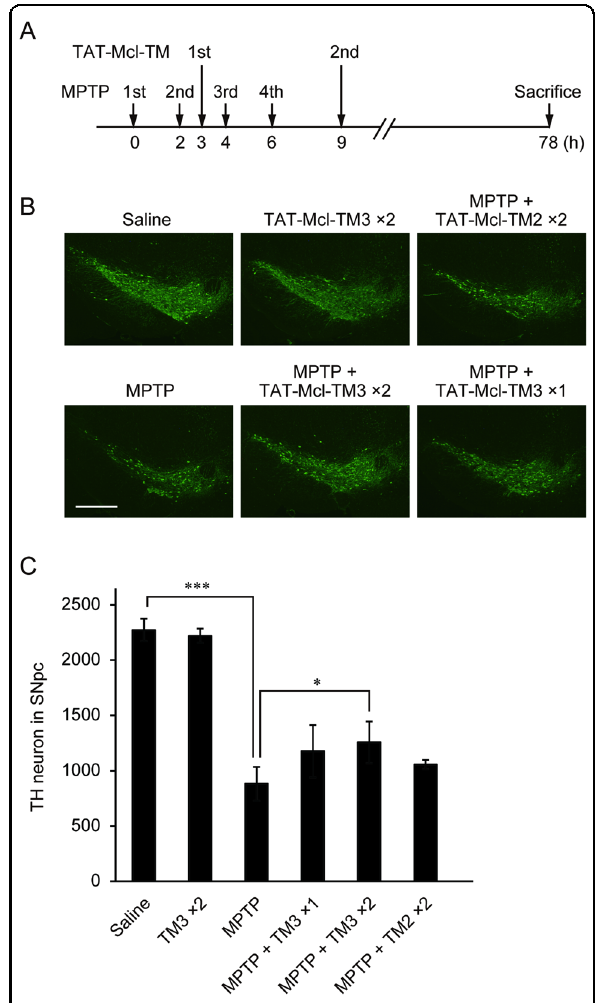
Fig. 4 Protective effect of TAT-Mcl-TM peptides on MPTP-induced neurodegeneration. A Schedule of injections of MPTP and TAT-Mcl- TM peptides. C57BL/6 J mice were intraperitoneally injected 4 times with MPTP and 1 or 2 times of a TAT-Mcl-TM peptide (200 μ g) at time points indicated by the arrows. B, C Decreased cell loss of TH-positive neurons in the SNpc of MPTP-injected mice by TAT-Mcl-TM peptides. Mice have administrated saline alone as a control (Saline), MPTP alone (MPTP), two doses of TAT-Mcl-TM3 (TM3×2), MPTP and a dose of TAT- Mcl-TM3 (MPTP + TM3×1), MPTP and two doses of TAT-Mcl-TM3 (MPTP + TM3×2), or MPTP and two doses of TAT-Mcl-TM2 (MPTP + TM2×2). Immuno fl uorescence analysis was performed using coronal sections through midbrains of treated mice. Every third section of each brain was immunostained for TH and observed with a fl uorescence microscope. Representative images were shown ( B ). scale bar, 500 μ